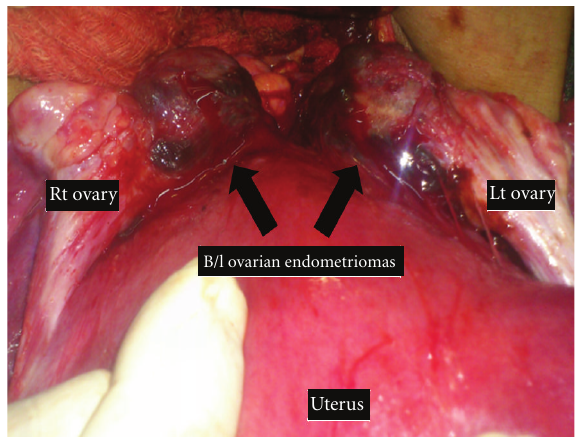
Figure 1: Bilateral ovarian endometriomas (black arrows) adherent to posterior uterine wall partially obstructing the